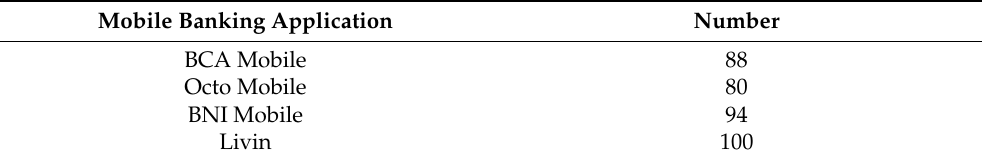
Table 1. The number of respondents of each mobile banking application.